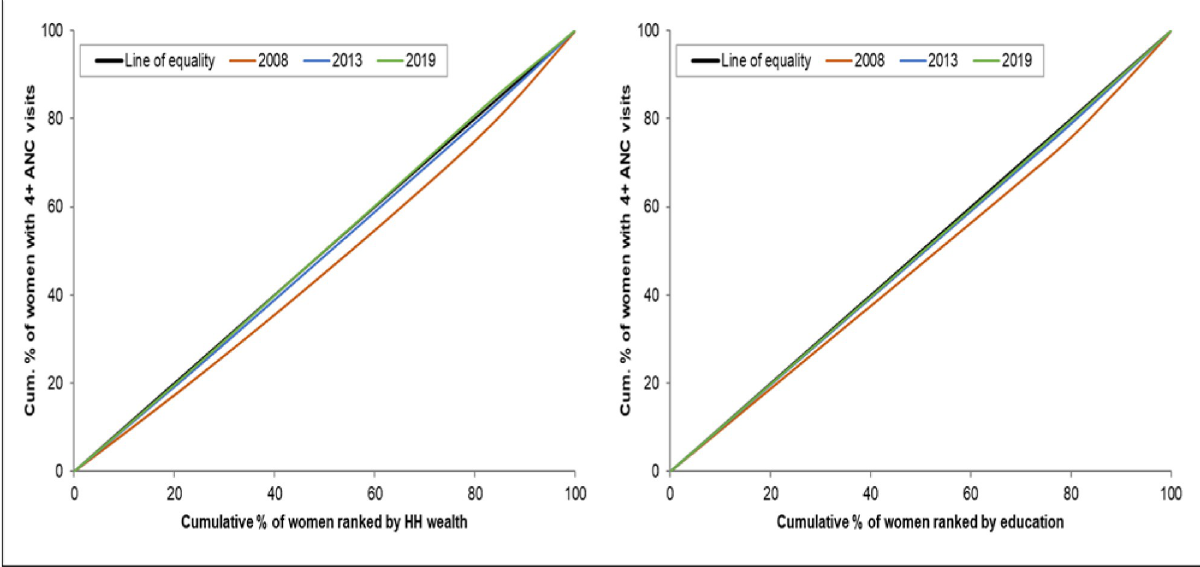
Fig 1. Concentration curves showing wealth-and-education-based inequality in the use of four or more antenatal visits in Sierra Leone, 2008, 2013 and 2019. https://doi.org/10.1371/journal.pone.0276102.g001 maternal healthcare use for about eleven years, from 2008–2019 (Tables 5 and 6). The biggest dant, which decreased from 0.330 to 0.113 for wealth-based inequalities and 0.230 to 0.095 for